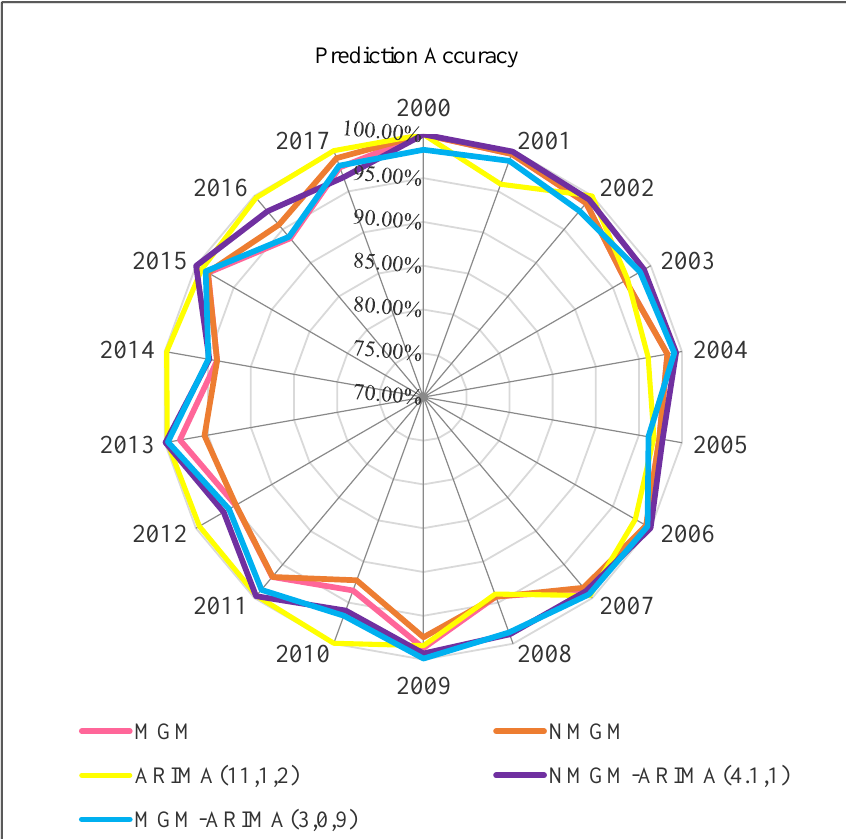
Figure 11. Goodness of fit for Five Models at different time points.